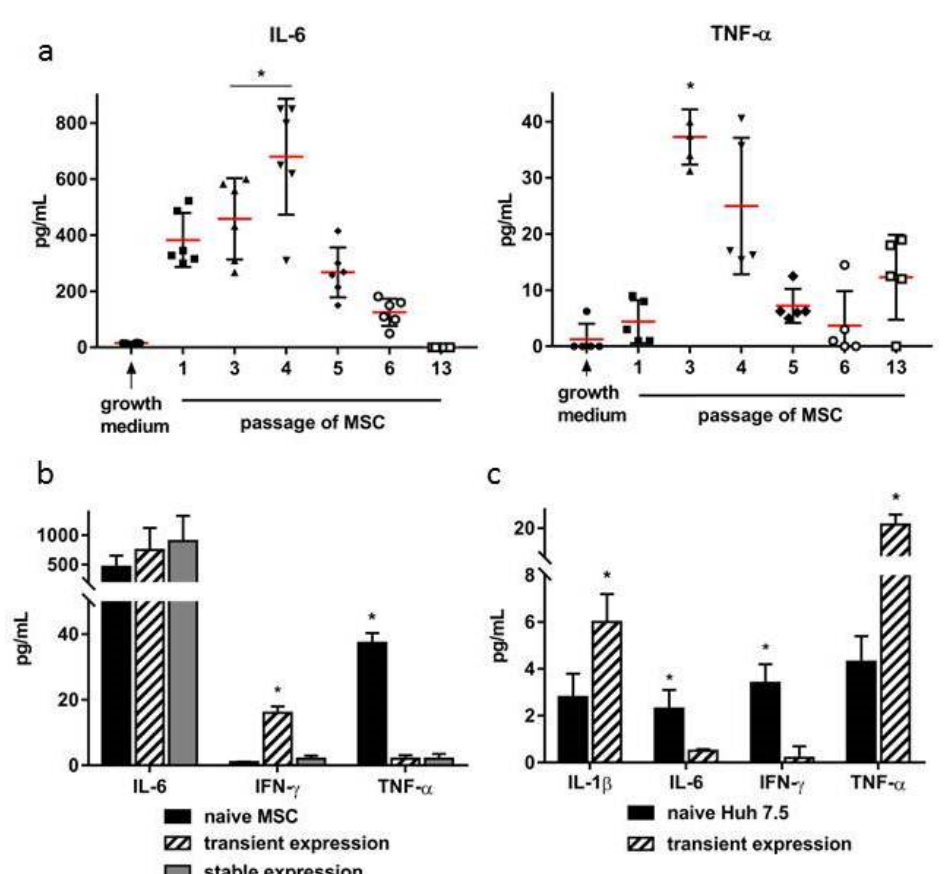
Figure 2. The changes in cytokine levels in a conditional medium during cultivation and transfection of mouse MSCs and human hepatoma cells. ( a ) The concentrations of IL-6 (left) and TNF- α (right) in the conditional medium during the cultivation of MSCs in the dynamics; ( b ) the concentration of cytokines secreted by naïve MSCs (passage 3), MSCs transfected with the pcNS3-NS5B plasmid (72 h), and MSCs stably expressing NS3-NS5B genes (transfection and selection using G-418, day 15); ( c ) comparative level of cytokine production by naïve Huh7.5 cells and cells transfected with the plasmid pcNS3-NS5B (72 h). The concentrations of cytokines are expressed in pg/mL. Values on each diagram are the means ± SD for three independent experiments; * p < 0.05 compared to the first passage MSCs ( a ) and naïve non-transfected MSCs ( b ) or Huh7.5 ( c ).